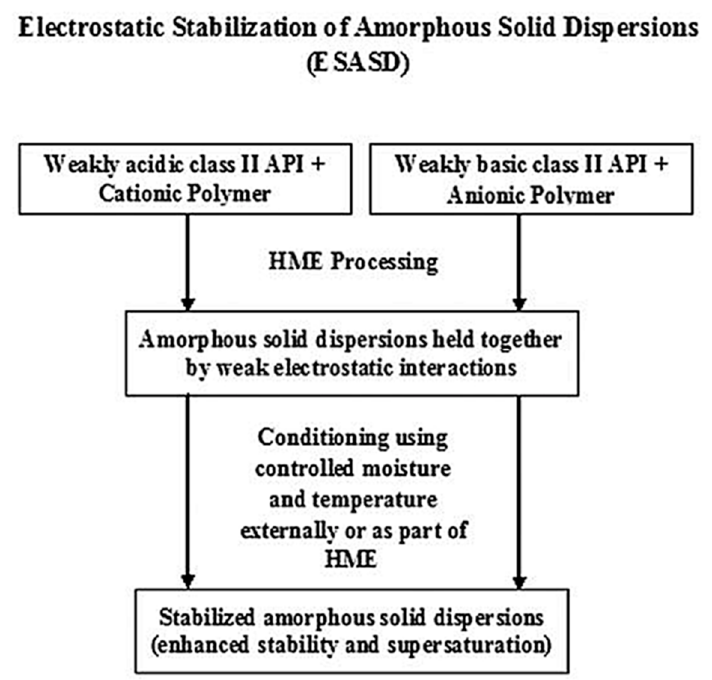
Figure 8. Electrostatic stabilization of amorphous solid dispersions of polyelectrolytes under con- trolled moisture and temperature conditions. (Adapted with permission from [86], American Chemi- trolled moisture and temperature conditions (Adapted with permission from [86], American Chem- cal Society, ical Society, 2013.)